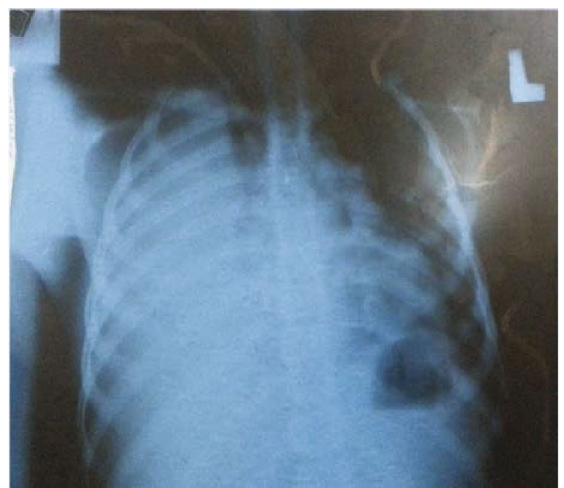
Figure 1: Chest roentgenography of the patient showing massive right pleural e ff